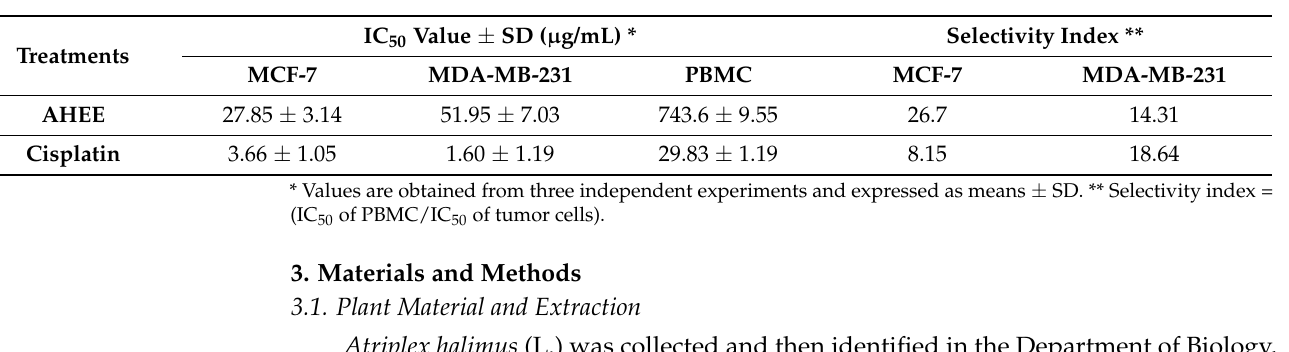
Table 9. IC 50 values and selectivity indexes of A. halimus ethanolic extract on MCF-7 and MDA-MB- 231 human breast cancer cell